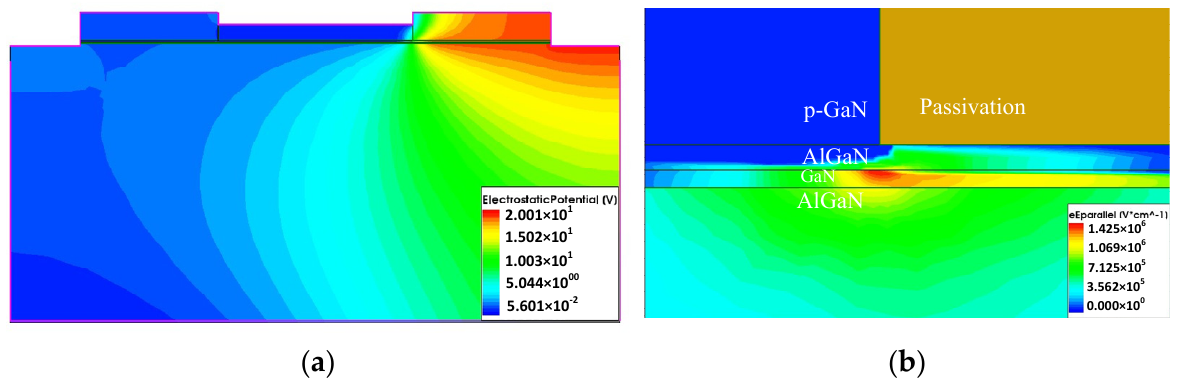
Figure 8. ( a ) Internal electric potential distribution of the device with self-heating effect; ( b ) electric field distribution near the hot spot.